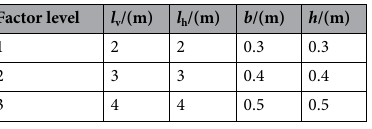
Table 3. Values of the frame structure parameters.